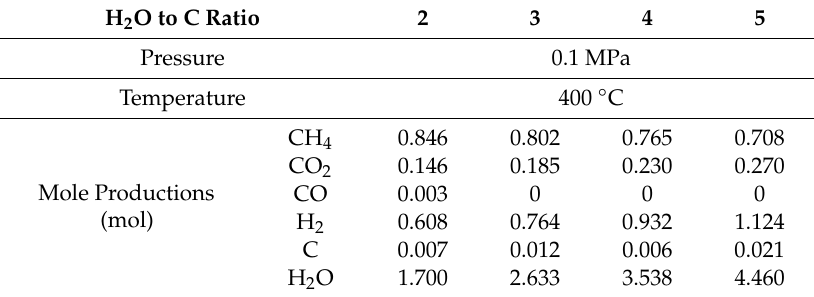
Table 1. Experiment results of the methane-steam reforming (mol).